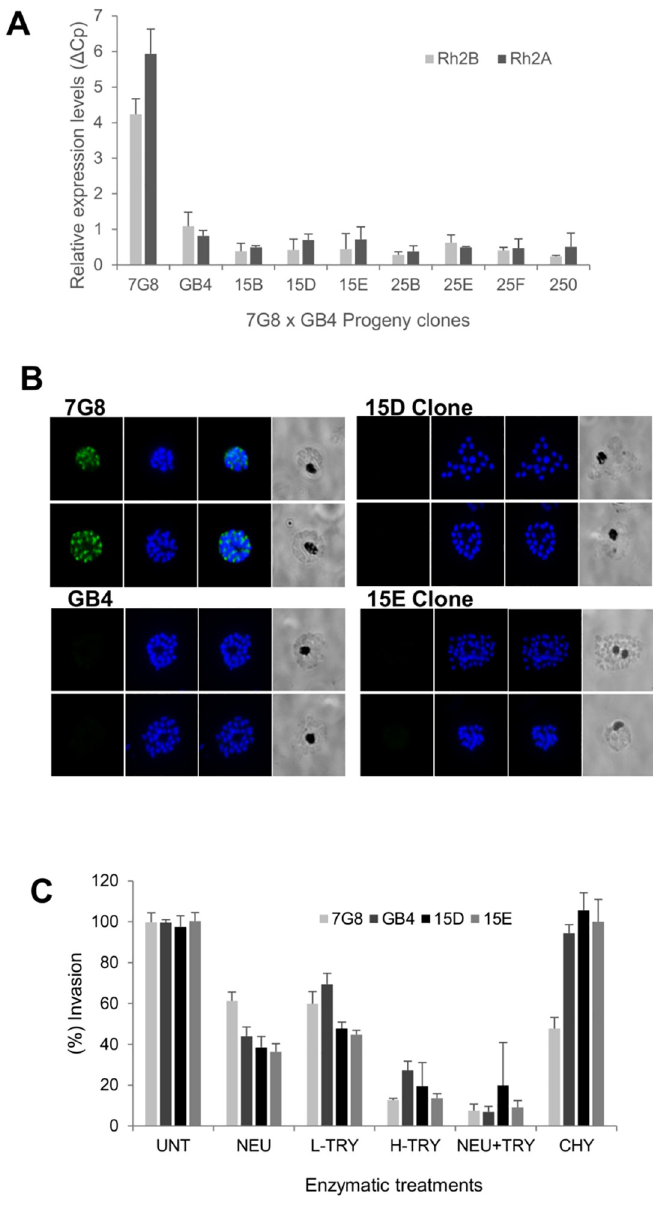
Fig 5. Gene editing and phenotyping of P . falciparum 7G8 strain to eliminate PfRh2a and PfRh2b expression. PfRh2b and PfRh2a were targeted in 7G8 using CRISPR/Cas9 technology and several clones were obtained from the resulting transfectant population. A) Expression of PfRh2b and PfRh2a genes for the parental lines 7G8 and GB4 and the edited 7G8 clones. B) Immunofluorescence analysis of the parental lines 7G8 and GB4 and two of the edited 7G8 clones using a specific anti-Rh2b antibody (green), nuclei are labelled with DAPI (blue). C) Invasion phenotypes of the edited 7G8 clones and the parental lines into erythrocytes untreated (UNT) or treated with neuraminidase (NEU), low trypsin (L-TRY), high trypsin (H-TRY), neuraminidase + trypsin (NEU+TRY) and chymotrypsin (CHY).